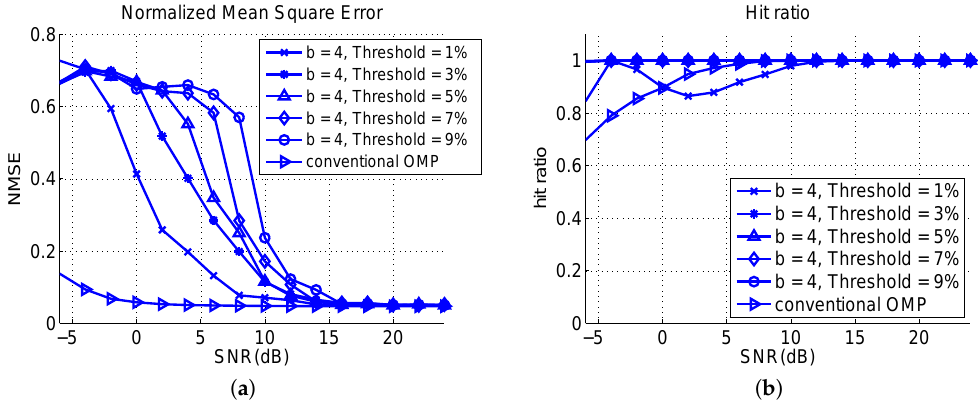
Figure 9. Analysis results of ( a ) normalized mean square error (NMSE) and ( b ) hit ratio for different